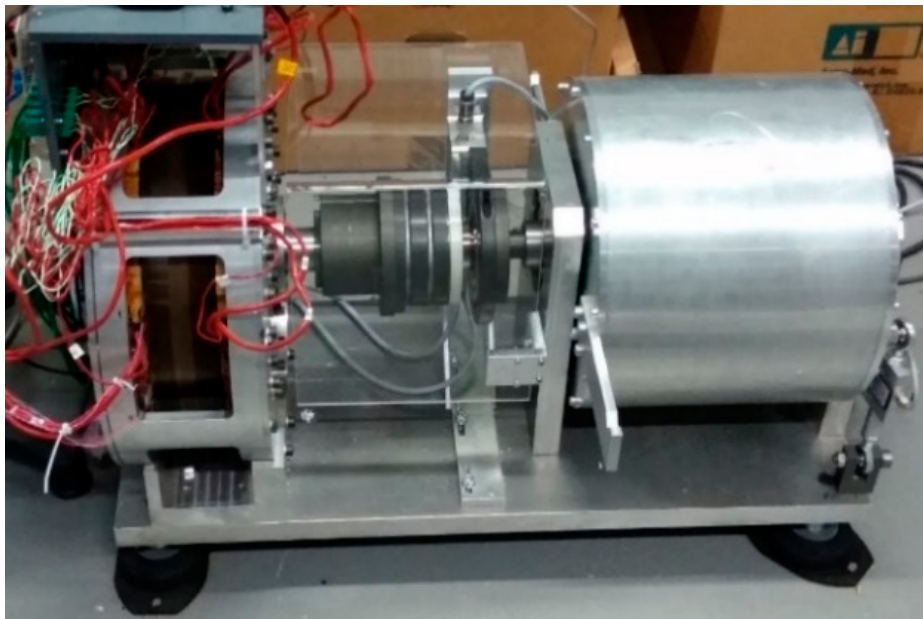
Figure 17. Assembled AFSPM prototype connected to the prime mover.